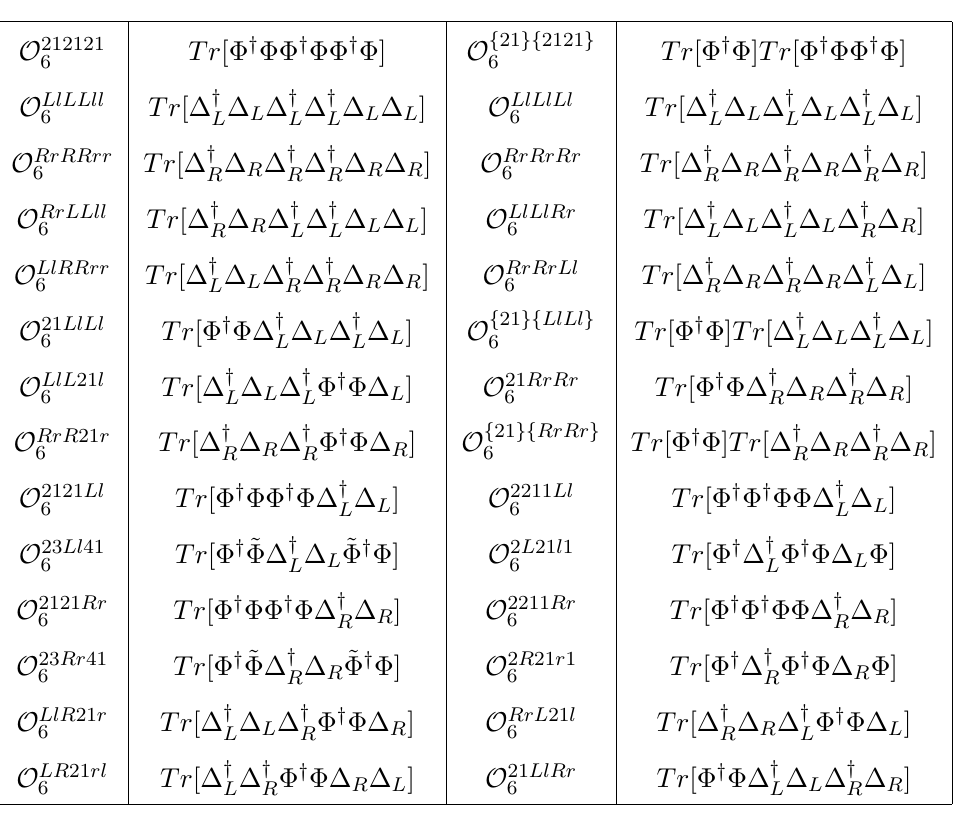
Table 18. MLRSM: (cid:30) 6 [28] class of operators. These operators are Self-Hermitian.